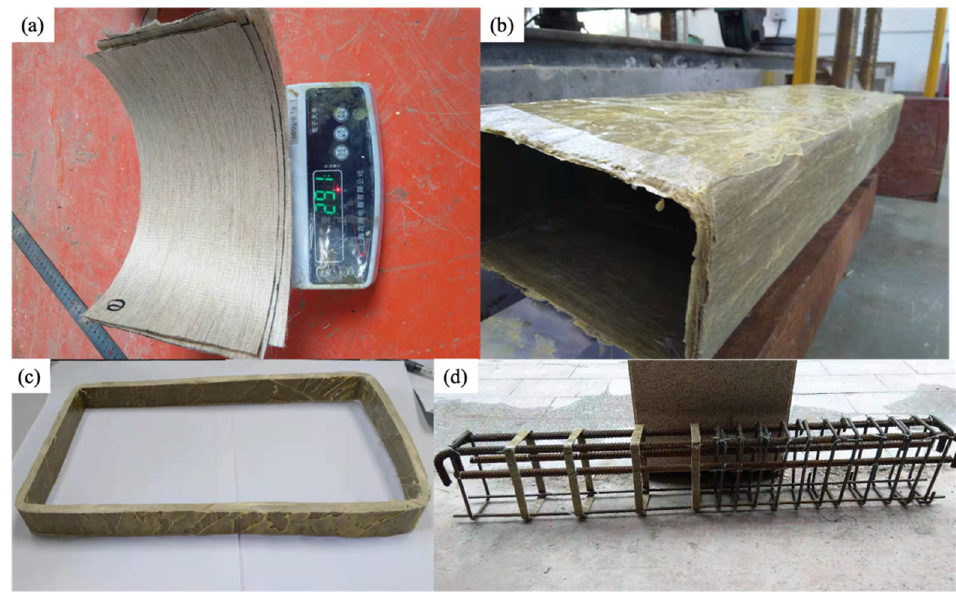
Figure 3. FFRP stirrups: ( a ) flax fabric; ( b ) flax FRP tube; ( c ) FFRP stirrup; and ( d ) steel cage.